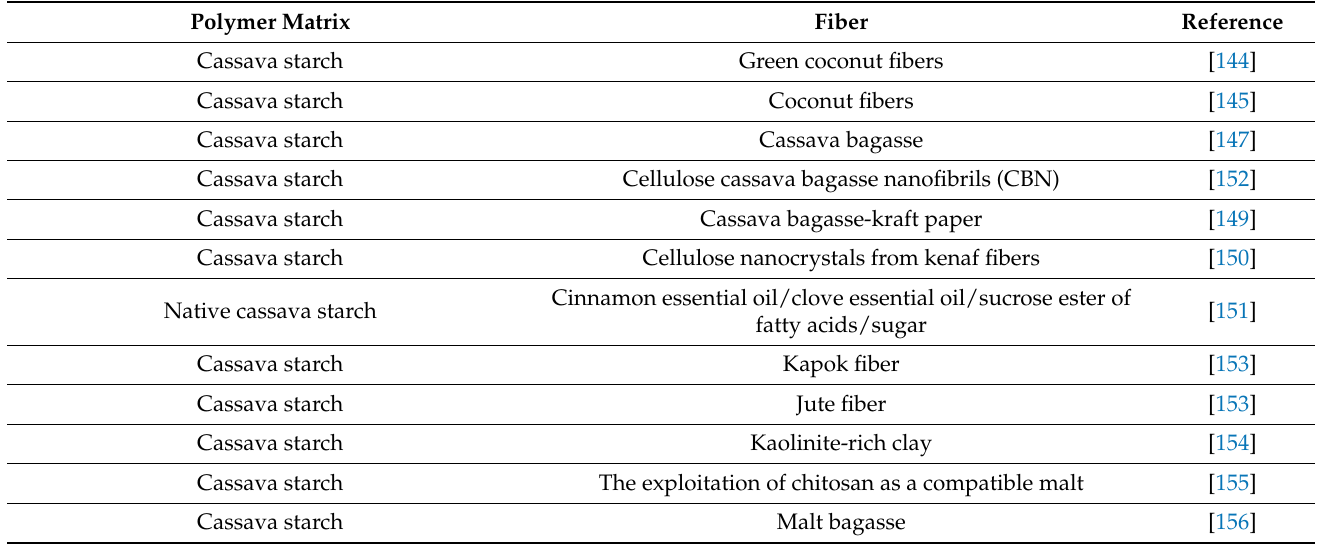
Table 6. Reported works on natural fiber-reinforced cassava starch-based